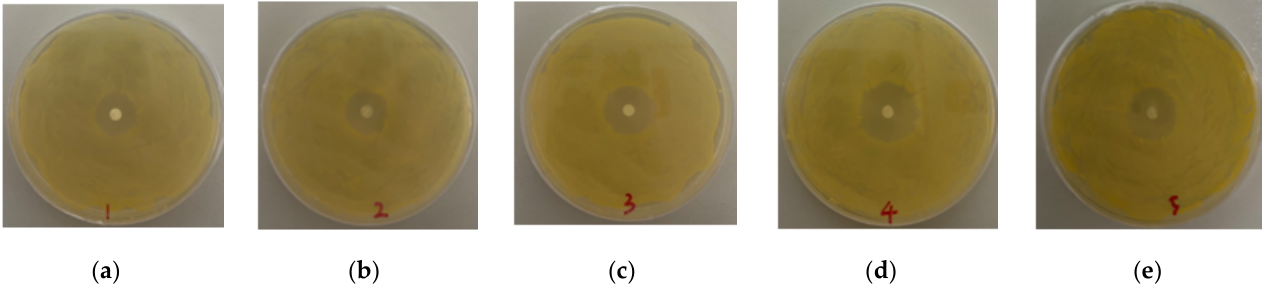
Figure 6. Photographs of the antibacterial test of ( a ) PPR1, ( b ) PPR2, ( c )PPR3, ( d ) PR1 and ( e ) PR2 after incubation for 24 h at 37 °C.